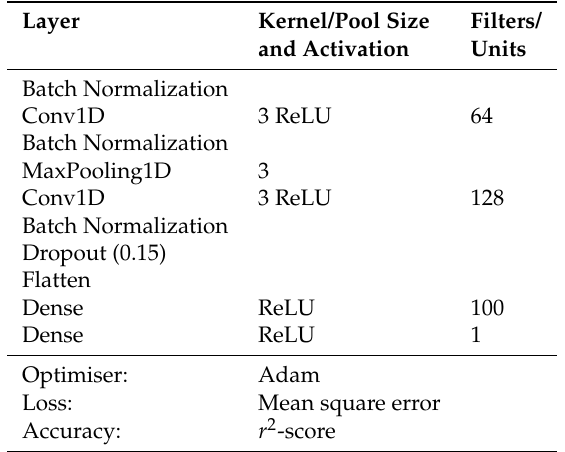
Table 3. The architecture of the used one-dimensional convolutional neural network (1DCNN).